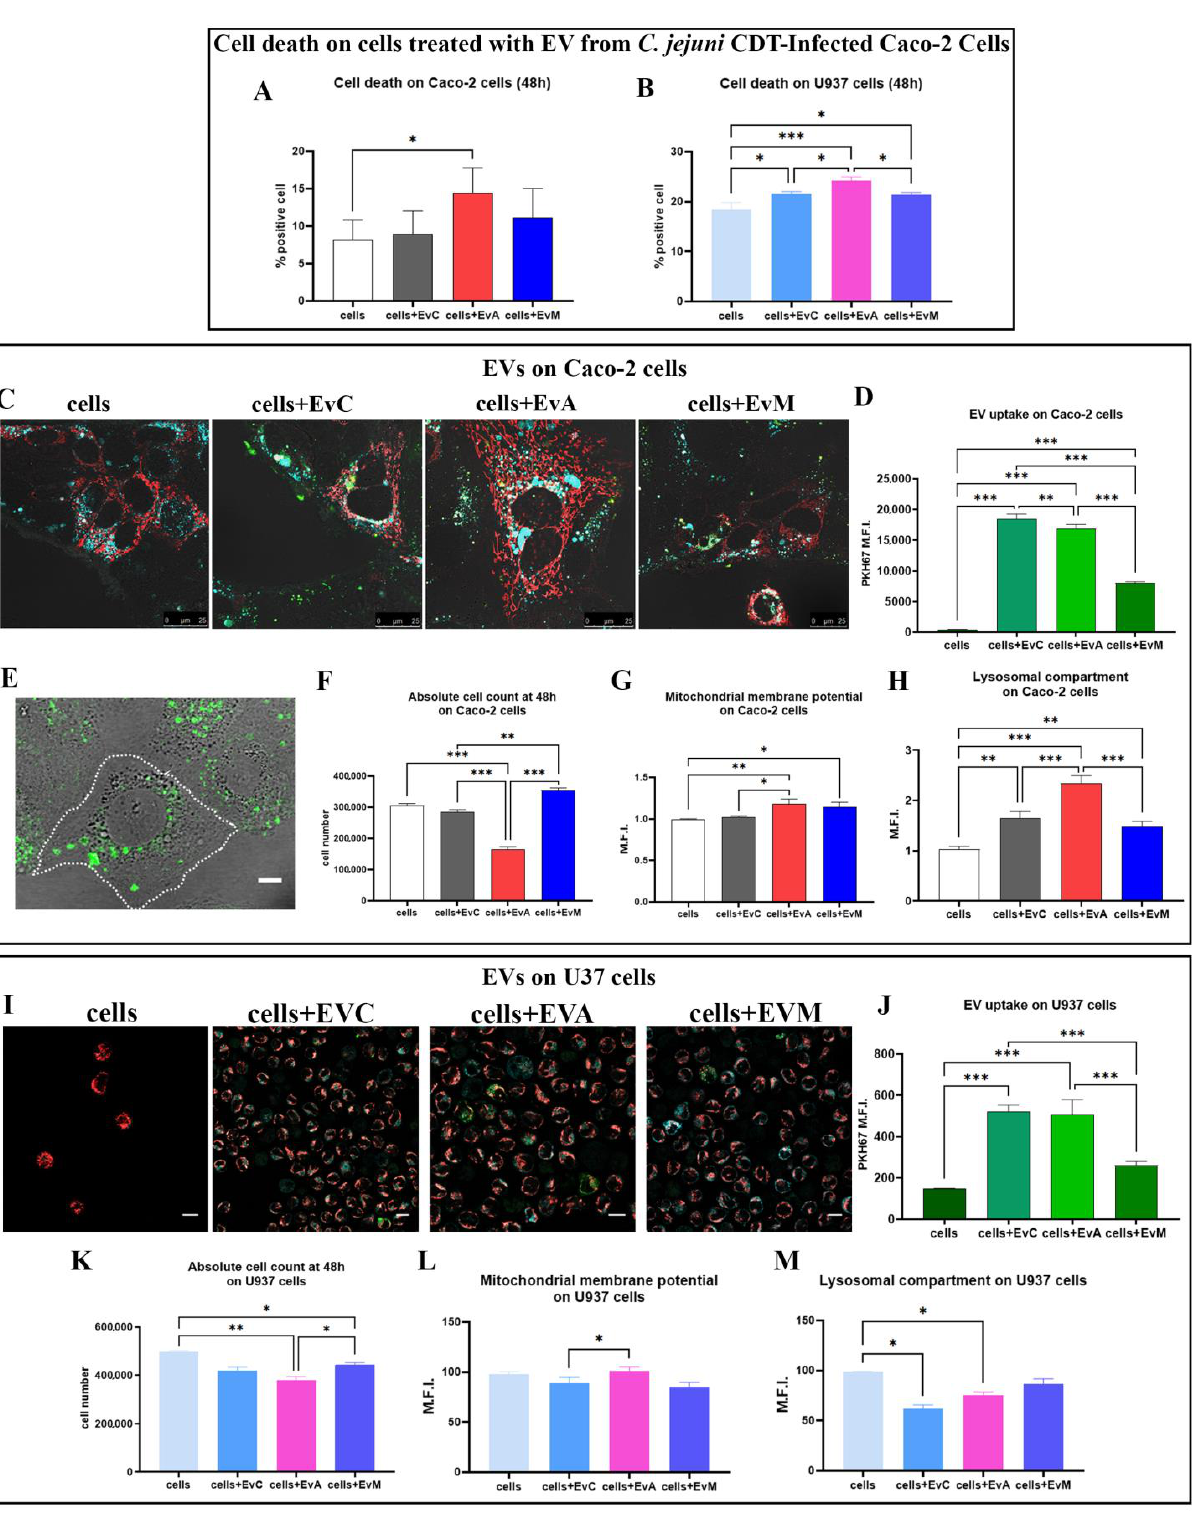
Figure 6. ( A ) Statistical histograms of the percentage of cell death on Caco-2 cells treated with EVs from the C. jejuni CDT-infected Caco-2 cells after 48 h. ( B ) Statistical histograms of the percentage of cell death on the U937 cells treated with EVs from the C. jejuni CDT-infected Caco-2 cells after 48 h. ( C ) Single confocal optical sections display an overlay of the mitochondria (TMRE red), lysosome (LTDR cyan), and EVs (PKH67 green) at 48 h for the cells, cells + EvC, cells + EvA, and cells +